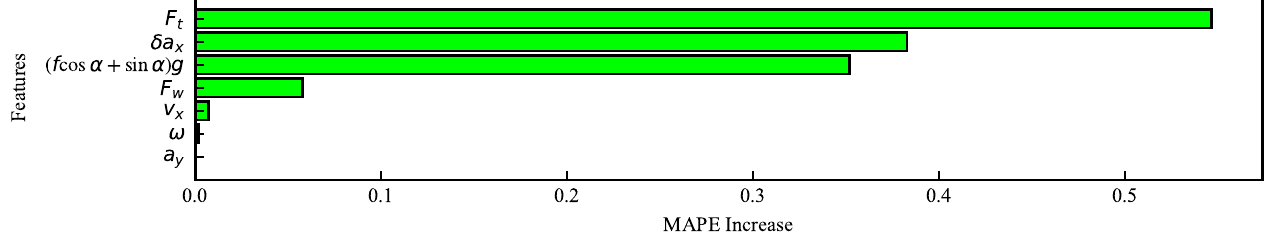
Table 5. Evaluation computing time of weight adjustment.